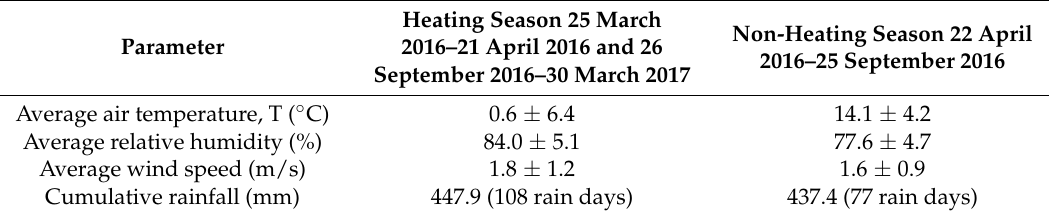
Table 1. Meteorological